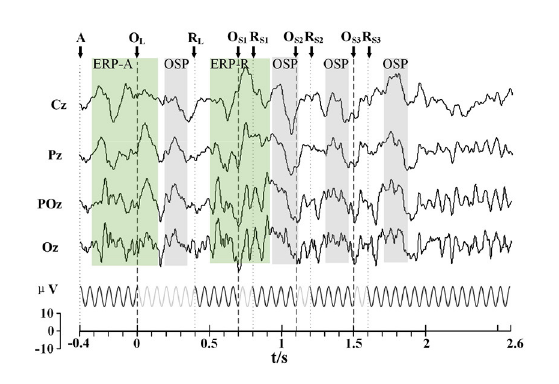
FIGURE7 Stimulus sequence and the typical EEG response of the stimuli with four omitting events (64 trials). The Green shaded area represents the primary ERP features, while gray shaded areas represent the primary OSP features. The classical peaks of OSP and ERP features are marked with square dots.